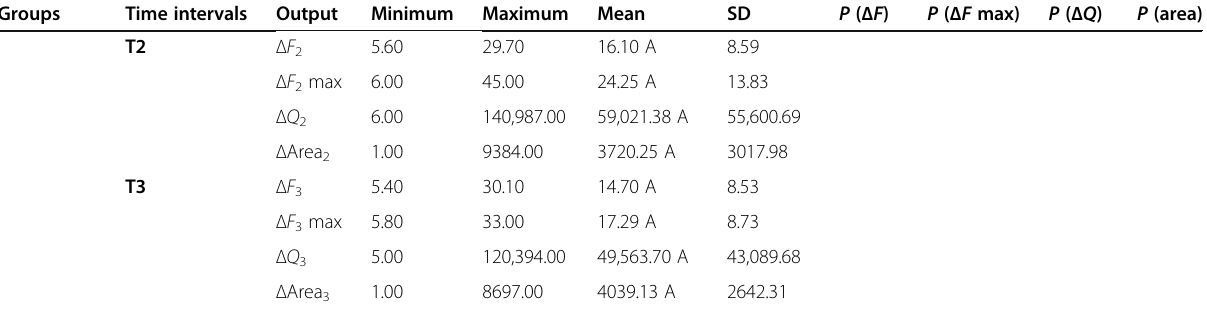
Table 2 Intragroup comparisons of QLF scores between timeline intervals (Continued) Groups Time